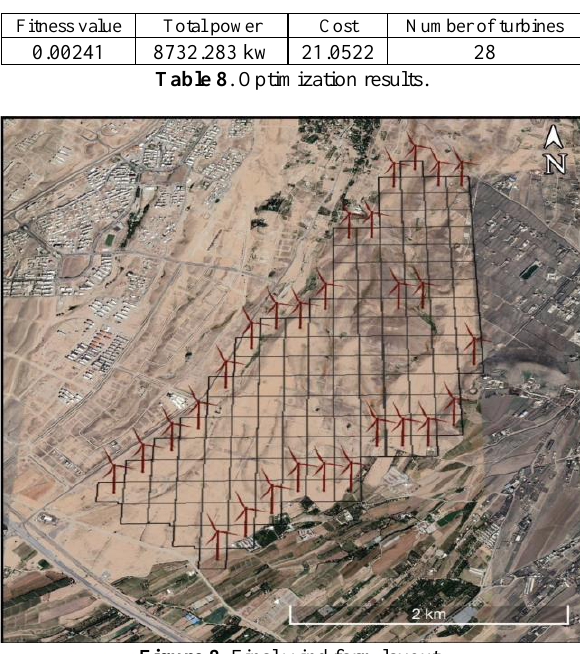
Figure 8 . Final wind farm